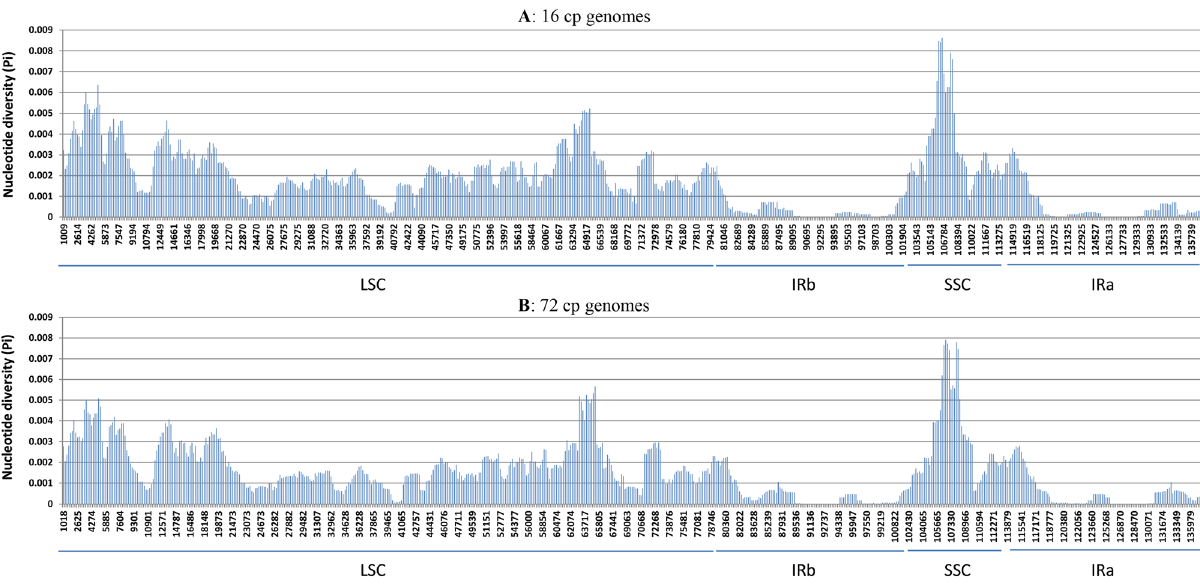
Figure 2. Nucleotide diversity (Pi) from the sliding window analysis of the 16 complete Triticum and Aegilops chloroplast genome assemblies generated in this study ( A ) and published 72 circular chloroplast genome sequences ( B ) (window length: 2000 bp, step size 200 bp). X-axis: position of the window midpoint, Y-axis: nucleotide diversity within each window. Note that the plots were generated in Microsoft Excel based on the outputs from DnaSP 6 software 49